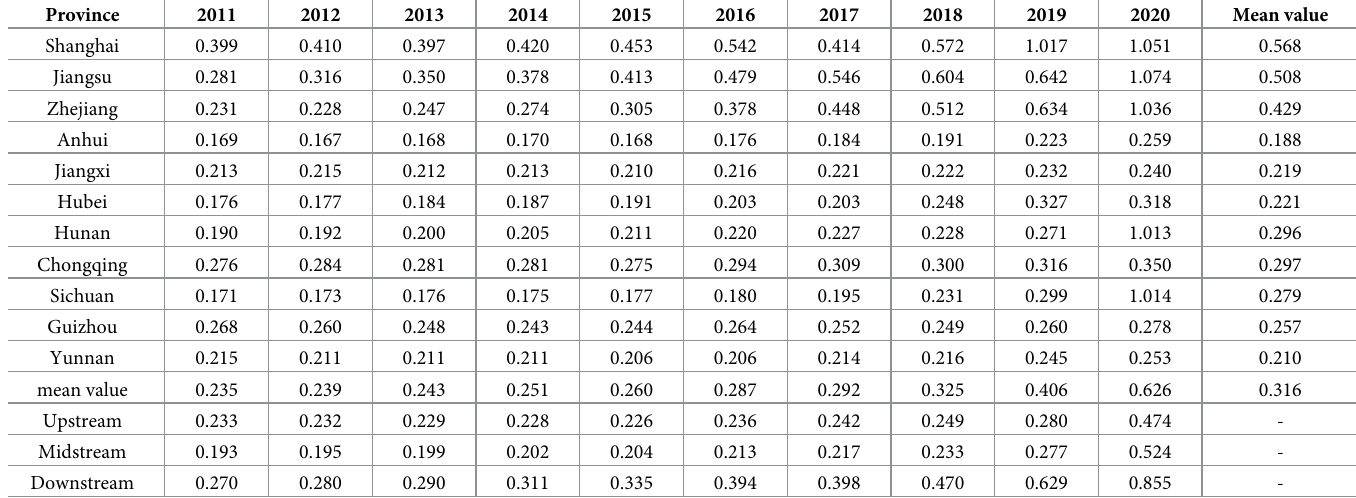
Table 3. Evaluation results of industrial eco-efficiency of Yangtze River Economic Belt.